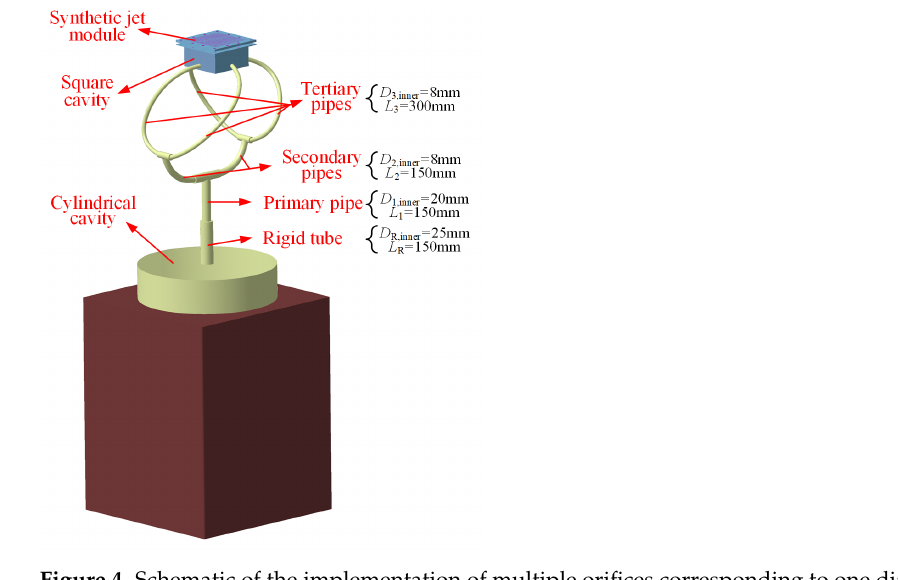
Figure 4. Schematic of the implementation of multiple orifices corresponding to one